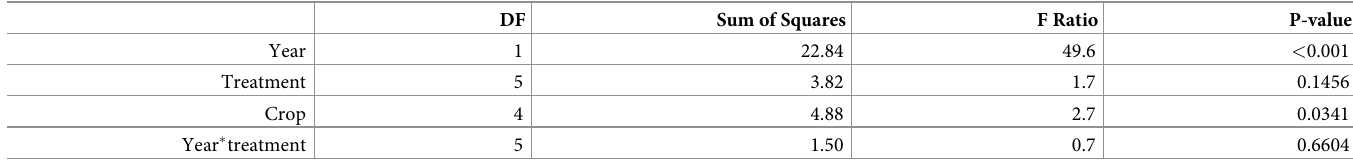
Table 4. Results of 3-way analysis of variance modeling log(leachate P) as a function of treatment, crop, year, and treatment � year interaction. R 2 = 0.21.